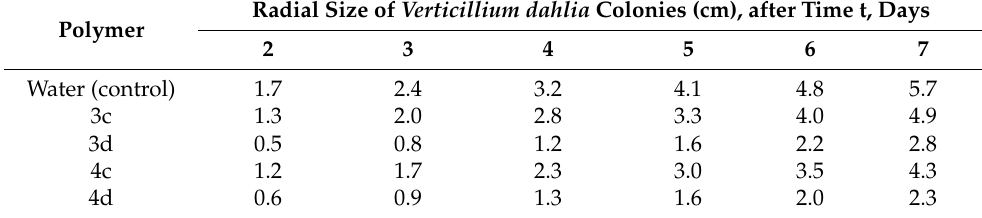
Table 4. Suppression of the radial growth of Verticillium dahliae colonies by silatrane-containing polymers 3c – 4d